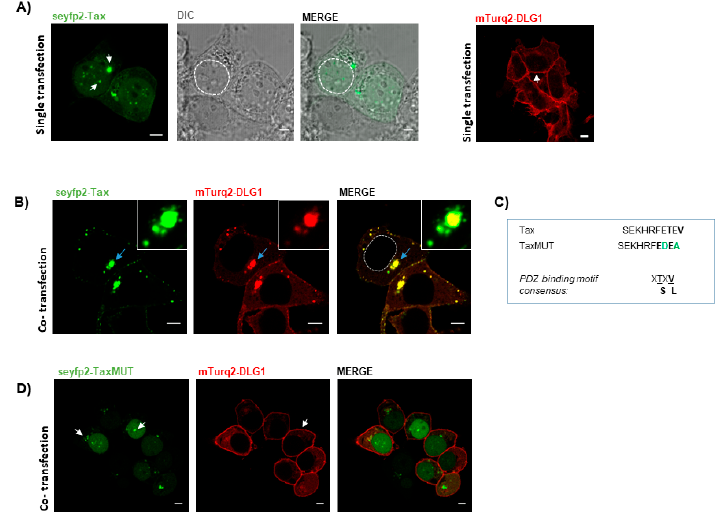
Figure 1. Simultaneous overexpression of discs large homolog 1 (DLG1) and human T cell leukemia virus (HTLV)-1 Tax (Tax) proteins generates a well-defined co-localization pattern. ( A ) Subcellular distribution of DLG1 and Tax proteins. Human Embryonic Kidney 293 (HEK293) cells transiently transfected with pseyfp2-Tax (green, left panel) or pmTurq2 -DLG1 (red, right panel) were fixed and protein expression was examined by confocal microscopy. The differential interference contrast (DIC) image is shown for better interpretation of nuclear localization; ( B ) Co-localization analysis of DLG1 and Tax. The pseyfp2-Tax and pmTurq2-DLG1 plasmids were simultaneously transfected into HEK293 cells and DLG1-Tax co-localization was assessed. The dashed circle delineates the nuclear region; ( C ) C-terminal sequence of Tax. The PBM of the Tax protein is highlighted with bold letters. Amino acid substitutions (green letters) introduced into the Tax PBM are shown with respect to the wild type Tax sequence. The consensus PBM sequence is also shown; ( D ) Co-localization analysis of DLG1 and Tax C-terminal mutant derivative (TaxMUT). The pseyfp2-TaxMUT (green) was transfected in HEK293 cells along with the pmTurq2-DLG1 plasmid (red). The co-localization between the proteins was assessed by confocal microscopy. In ( A , D ), the white arrows show the particular expression of each protein as described in the text. In ( B ), the light blue arrows indicate the co-localization region amplified in the inset. Dashed circles indicate nuclear regions. All scale bars represent 5 µm.